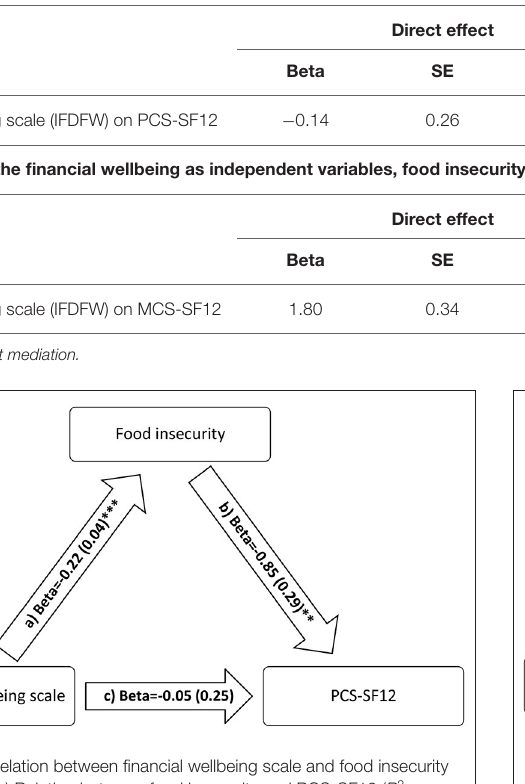
FIGURE 2 | a) Relation between financial wellbeing scale and food insecurity ( R 2 = 19.16%); b) Relation between food insecurity and PCS-SF12 ( R 2 =